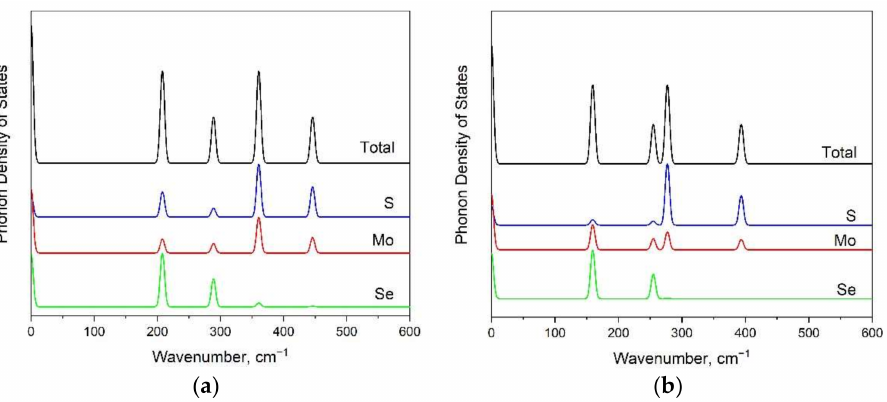
Figure 4. Total and partial phonon densities of states for 1H ( a ) and 1T ( b ) MoSSe